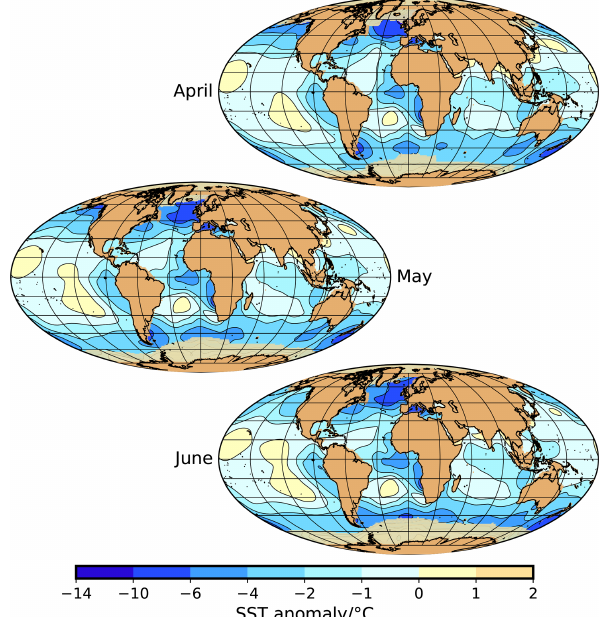
Figure A6. Sea-surface temperature anomaly (contour map) and sea-ice extent (yellow–brownish areas close to Antarctica and in the Arctic) for July, August, and September. For August, we also show the MARGO reconstruction at the sediment core locations (MARGO Project Members, 2009).